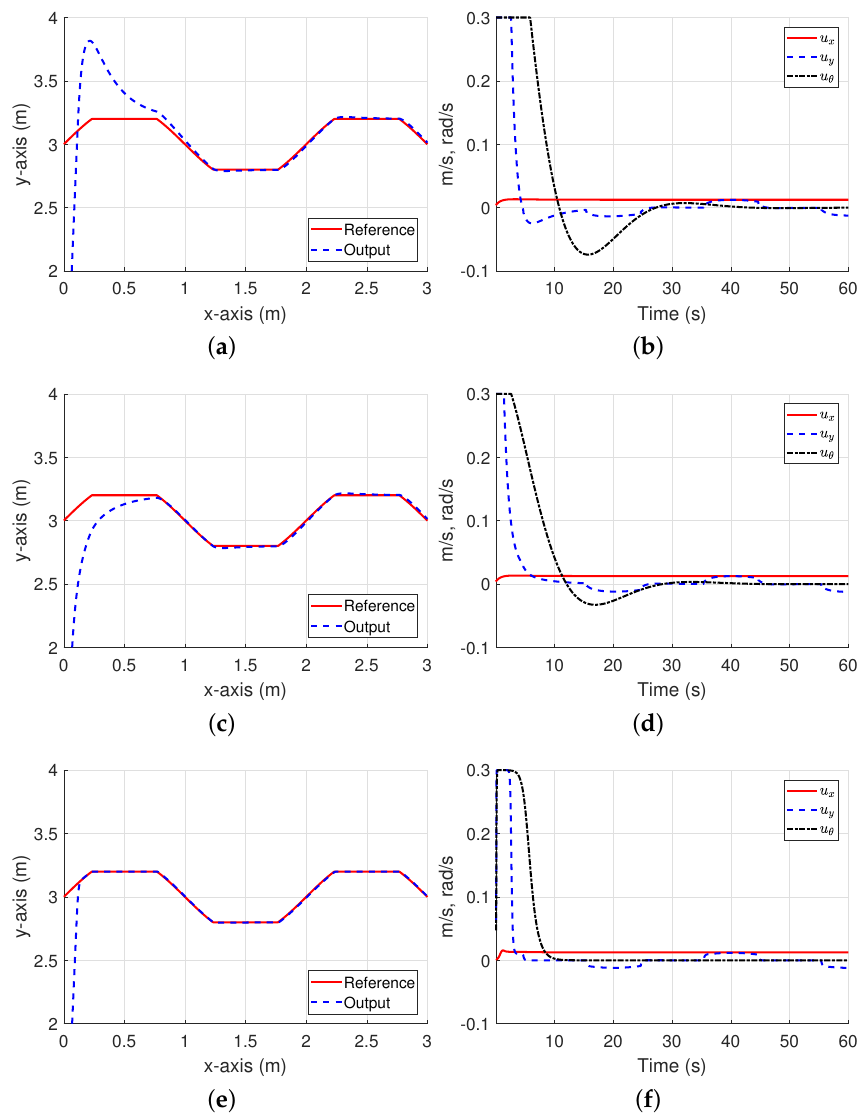
Figure 15. Trajectory following and Velocity control signal results for the trapezoidal trajectory with offsets. ( a ). Trajectory following for PID. ( b ) Velocity control signal of PID. ( c ) Trajectory following for PID with anti-windup. ( d ) Velocity control signal of PID with anti-windup. ( e ) Trajectory following for EKF-SNPID. ( f ) Velocity control signal of EKF-SNPID.